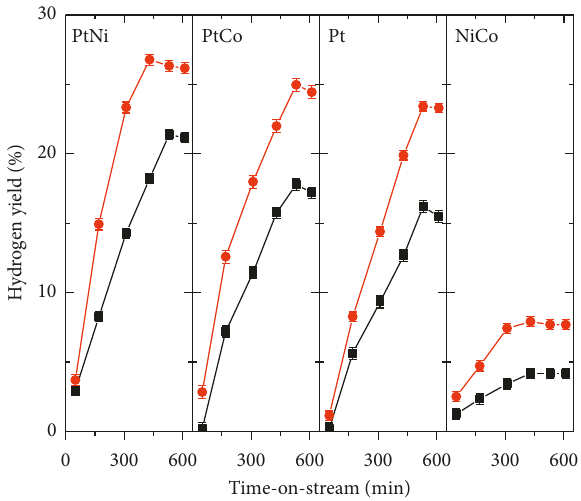
Figure 3: Hydrogen yield of the different catalysts. APR of ethylene glycol (10% aqueous solution). Fixed bed reactor, 498K 22bar,